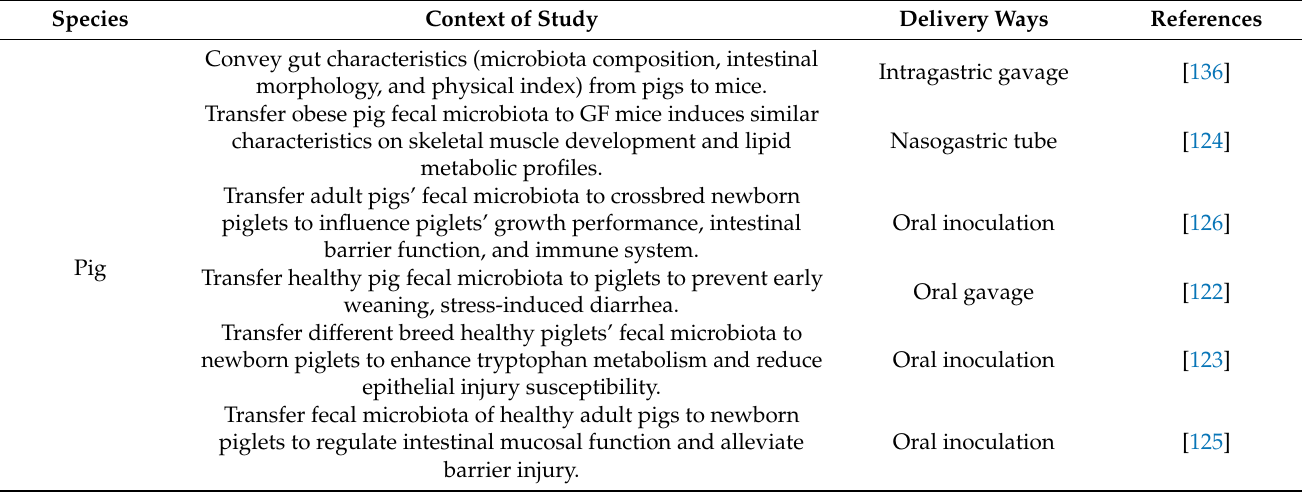
Table 1. Fecal microbiota transplanting applied in farm animals.